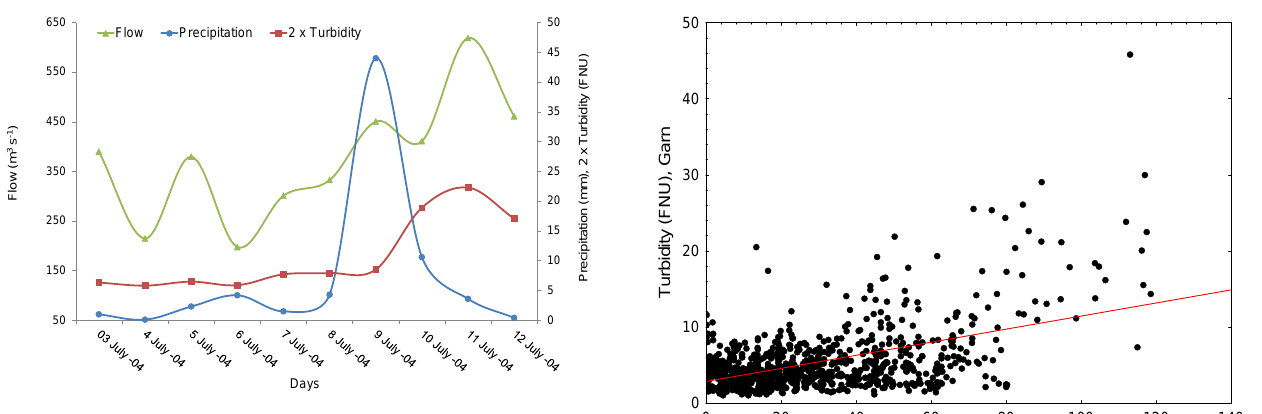
Fig. 5. A time series of daily mean values for precipitation, flow, and turbidity at Garn from 3 to 12 July 2004. Note that turbidity has been multiplied with 2 for a better resolution. Fig. 6. Correlation between turbidity and 9 days of accumulated rain at station Garn, 2004–2006 ( r =0.52, p <